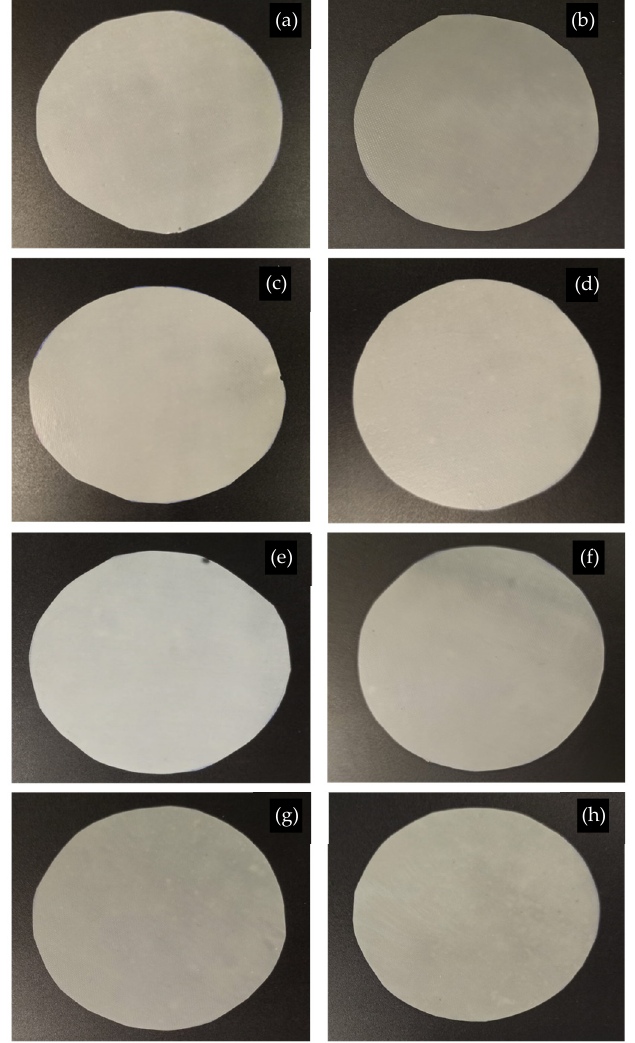
Figure 6. Films obtained by thermo-compression of poly(3-hydroxybutyrate- co -3-hydroxyvalerate) (PHBV) with microfibrillated cellulose (MFC) and compatibilized with epoxy-based styrene-acrylic oligomer (ESAO) and with triglycidyl isocyanurate (TGIC) and dicumyl peroxide (DCP) as follows: ( a ) PHBV; ( b ) PHBV_2.5%MFC; ( c ) PHBV_5%MFC; ( d ) PHBV_10%MFC; ( e ) PHBV_ESAO; ( f ) PHBV_TGIC+DCP; ( g ) PHBV_5%MFC_ESAO; ( h ) PHBV_5%MFC_TGIC+DCP.